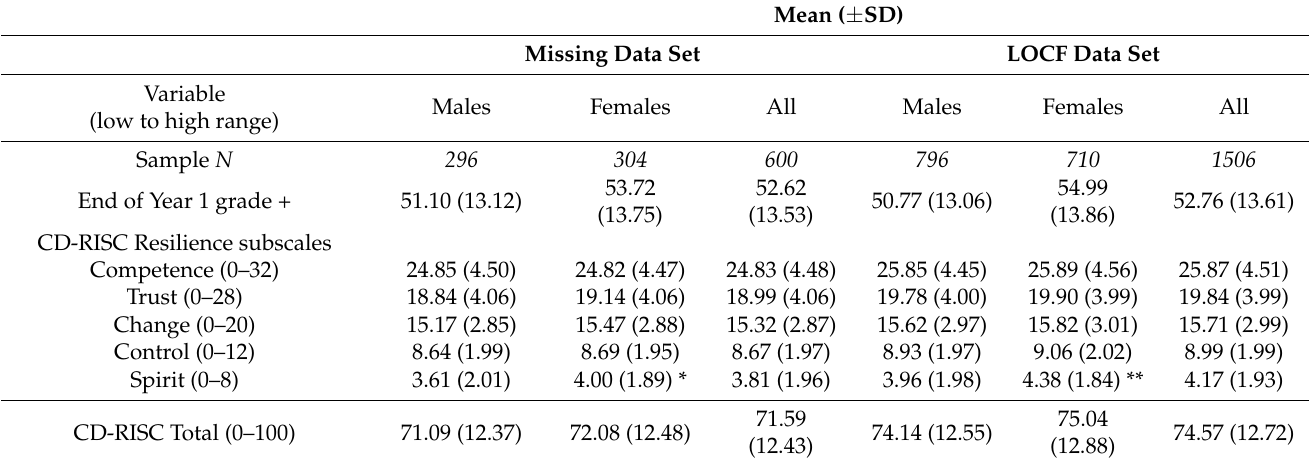
Table 4. CD-RISC follow-up (T3) Total Resilience (TR) and subscales with mean end of Year 1 grades. Mean ( ± SD)